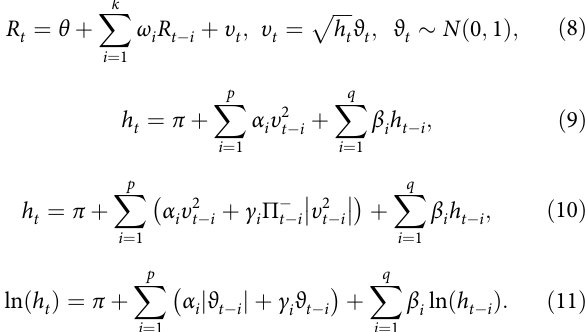
mality with the BFGS 17 optimisation algorithm. Following